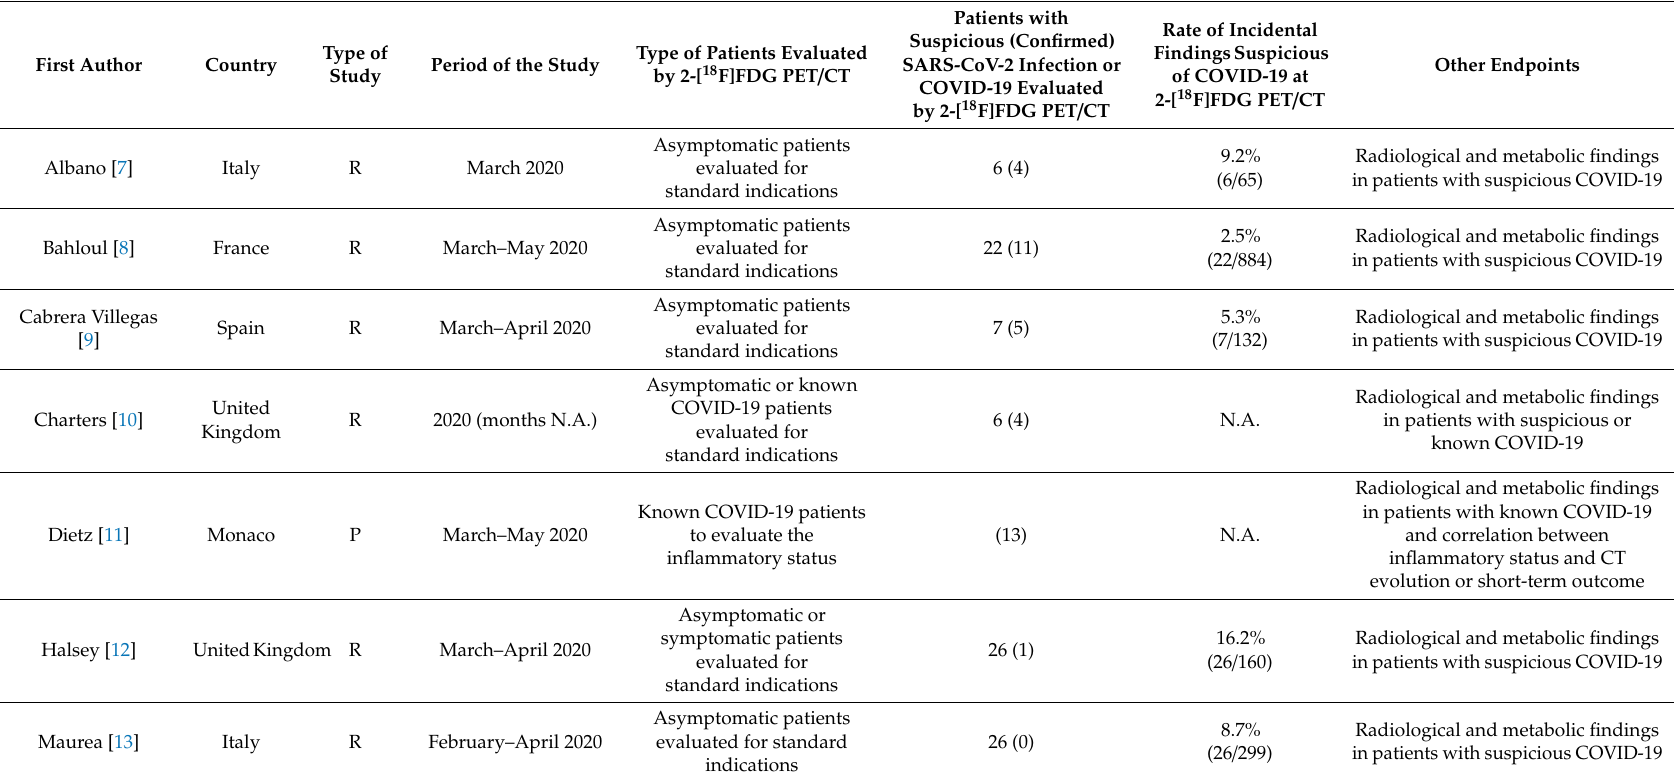
Table 1. Characteristics of included studies on the role of 2-[ 18 F]FDG PET / CT in patients with